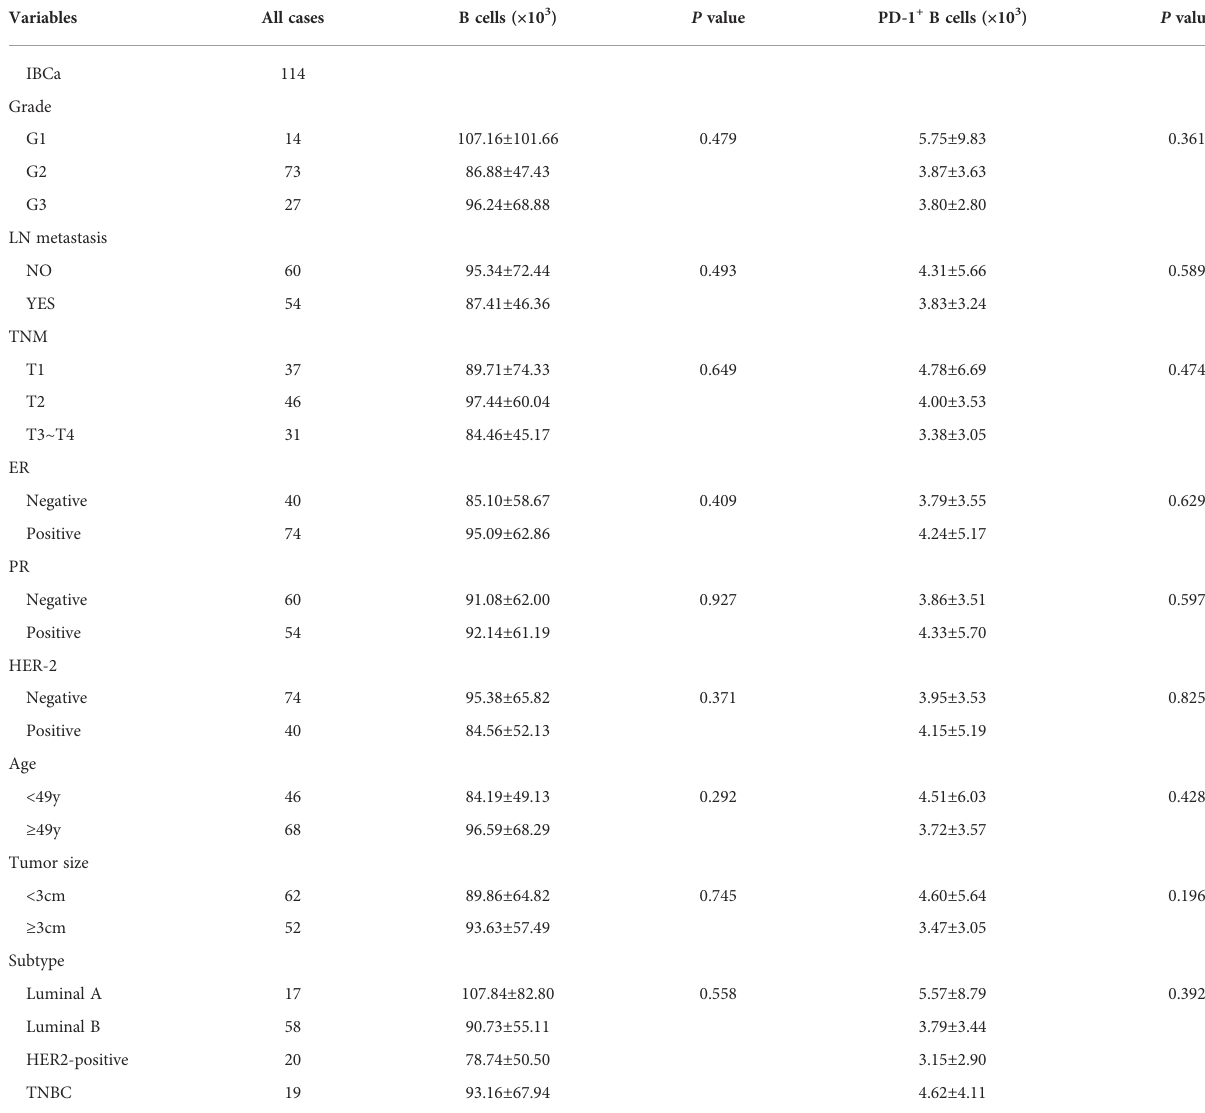
TABLE 3 Relationship between the absolute number of B cells and its subset in PBMCs and the clinicopathological parameters of IBCa patients.